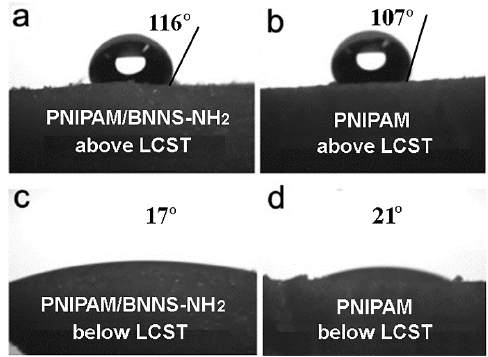
Figure 2. The pictures of contact angle: ( a ) PNIPAM/BNNS-NH 2 ; ( b ) PNIPAM at above LCST; ( c ) PNIPAM/BNNS-NH 2 and ( d ) PNIPAM at below LCST.